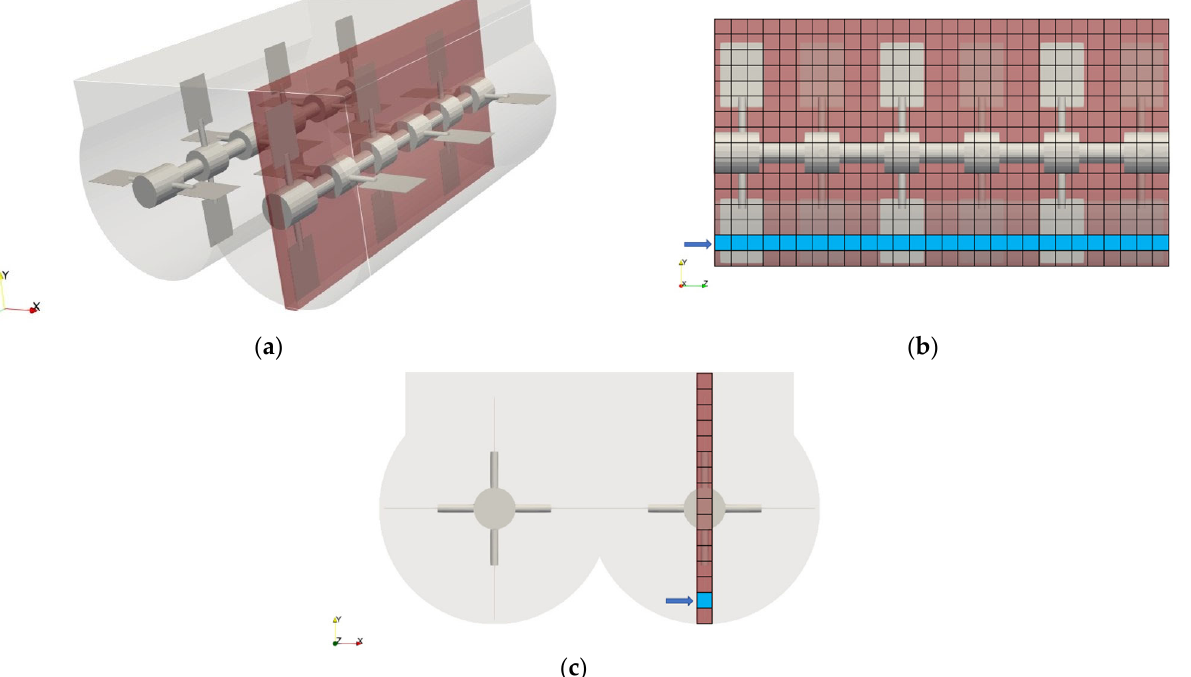
Figure 5. Plane and control volumes used for calculation of granular temperature profile from ( a ) Isometric, ( b ) Side, and ( c ) Front view.